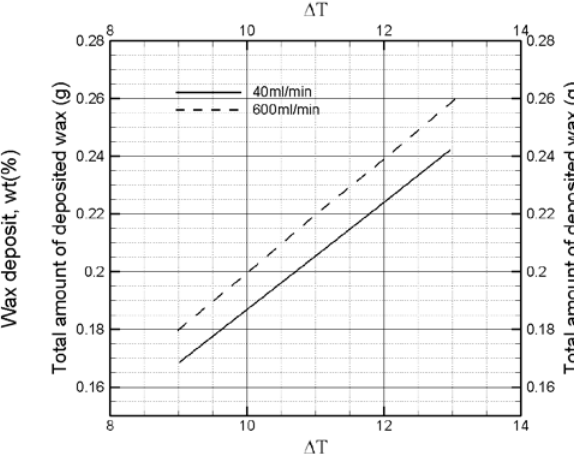
Figure 7 Effect on wax deposit (weight percentage) due to temperature differential at 300 min (Mahto and Kumar, 2013)